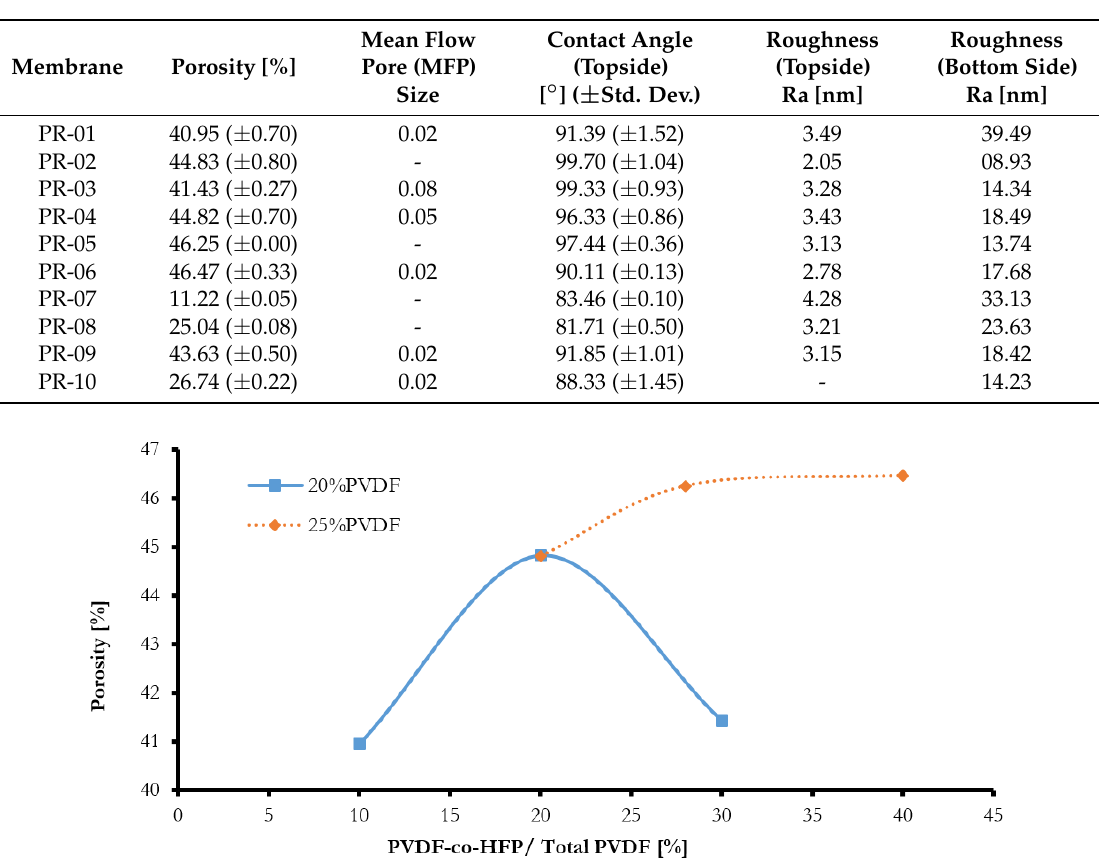
Figure 6. Effect of PVDF-co-HFP quantity on the blended membrane porosity with NMP as the solvent.